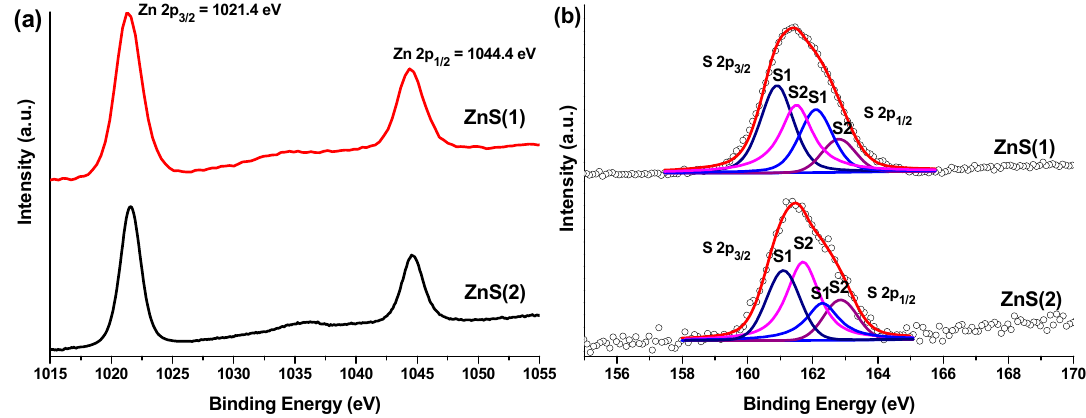
Figure 5. XPS spectra of samples ZnS(1) and ZnS(2): ( a ) Zn 2p and ( b ) S 2p.